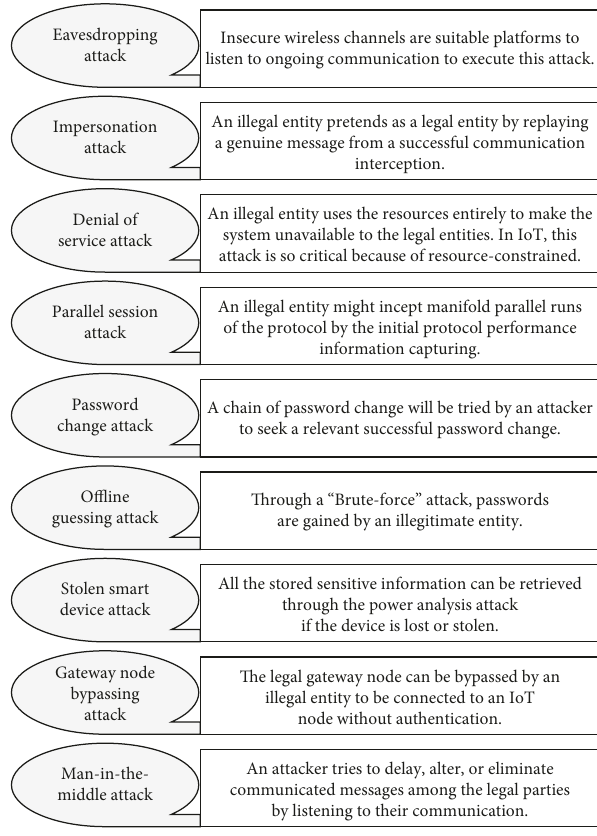
Figure 2: Security threats in the